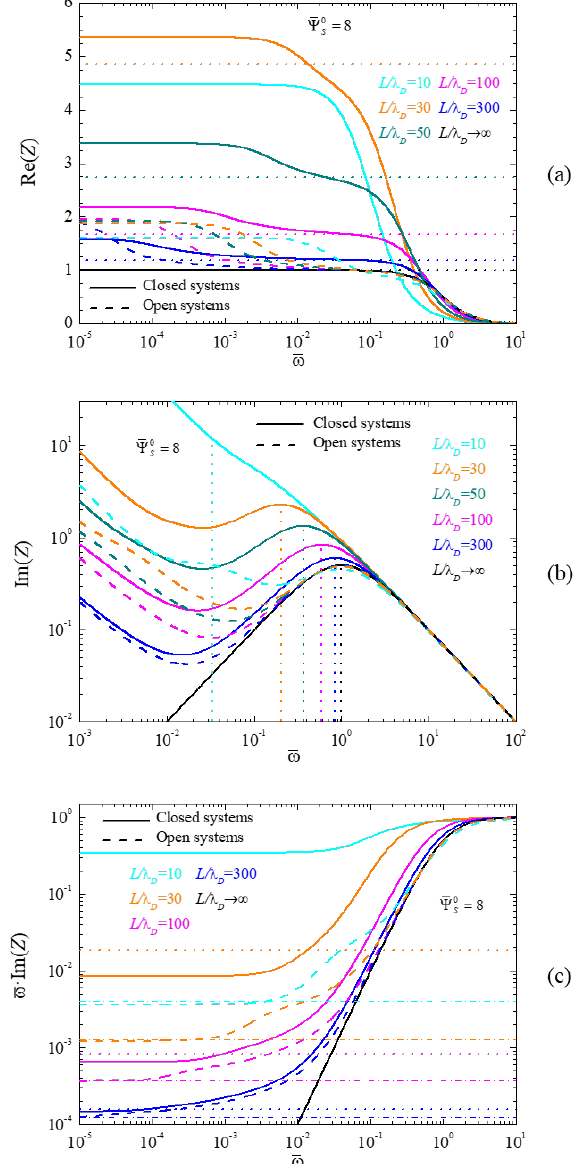
Figure 4. Spectra of the real part of the impedance ( a ), its imaginary part ( b ), and its imaginary part multiplied by the angular frequency ( c ), calculated for the indicated L / λ D values and the dimensionless surface potential Ψ 0 S = 8. Dot and dash-dot straight lines (closed and open cells, respectively) correspond to the following: ( a ) Real part of the impedance at frequencies between both dispersions, Equation (61) for open or (62) for closed cells; ( b ) characteristic frequency of the high- frequency dispersion, Equation (60) for closed cells; ( c ) Low-frequency limit of the imaginary part of the impedance multiplied by the frequency, Equations (63), (64), and (25) for closed or Equation (28) for open